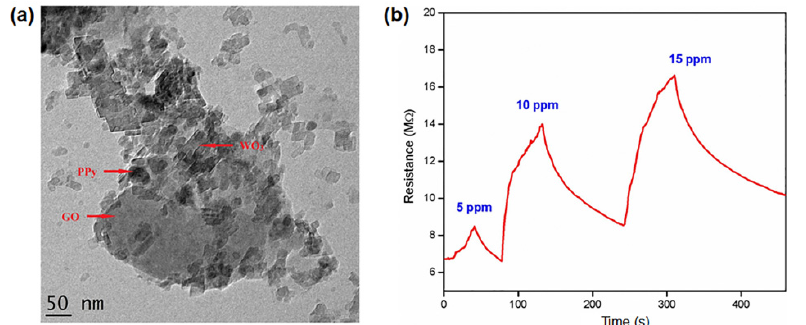
Figure 5. ( a ) Morphology of PPy–GO–WO 3 nanocomposite investigated by transmission electron microscopy; ( b ) electrical response of the PPy–GO–WO 3 nanocomposite to NH 3 gas (5–15 ppm). Reproduced with permission from Albaris et al., Mater. Sci. Eng. B: Solid-State Mater. Adv. Technol.; published by Elsevier, 2020 [148].